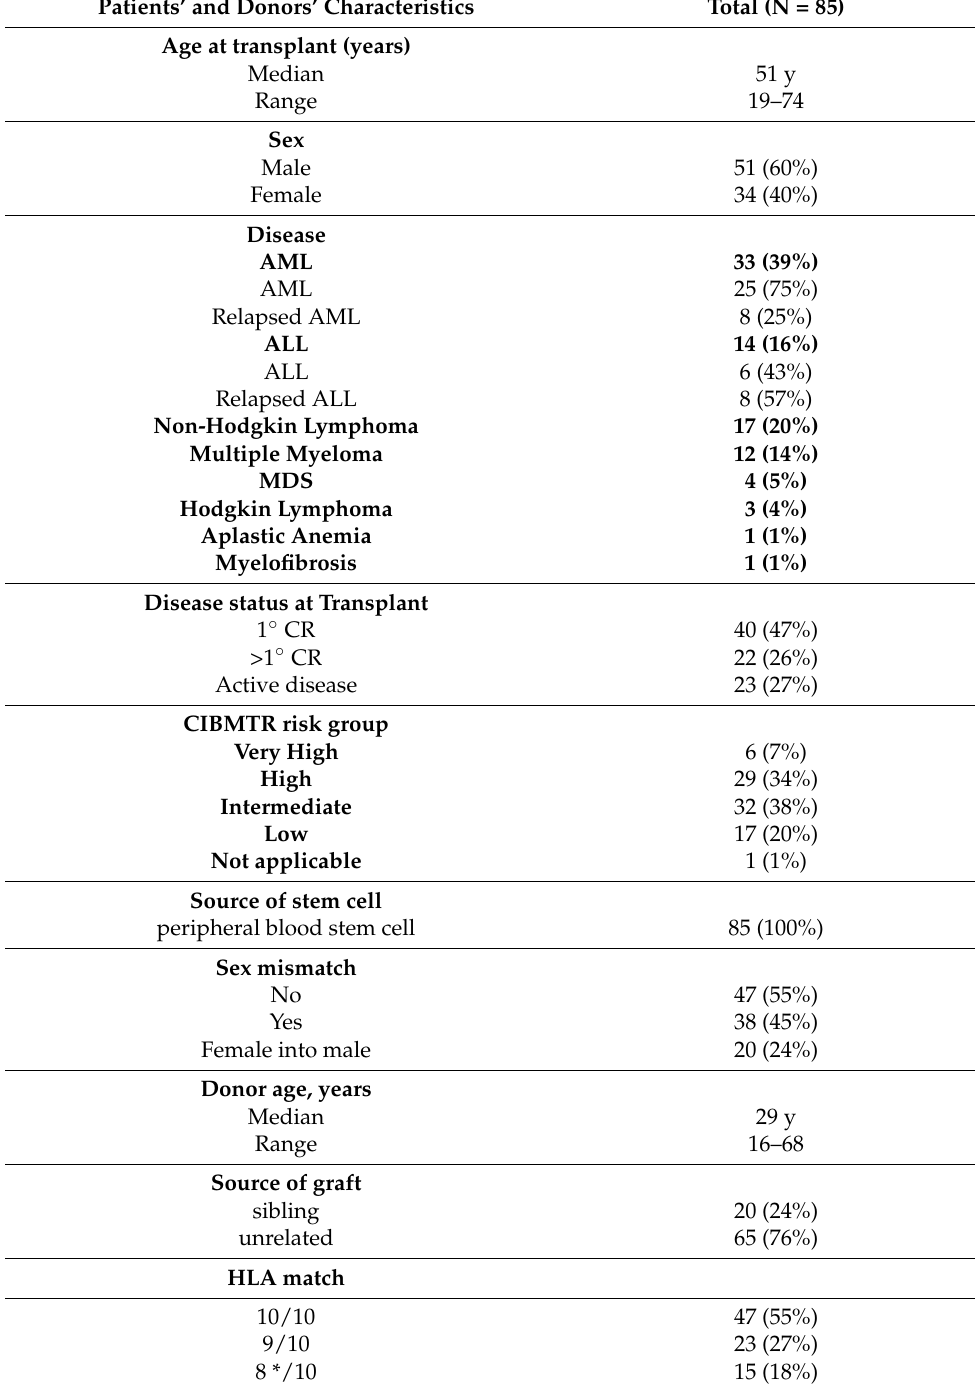
Table 1. Patient and Donor Characteristics. AML: acute myeloid leukemia; ALL: acute lymphoblas- tic leukemia; MDS: myelodisplastic syndrome; BMT: bone marrow transplantation; CR: complete response; MDR: minimal residual disease; TBI: total body irradiation; MMF: mofetil mycopheno- late; CMV (Cytomegalovirus); D (donor); R (recipient). Disease risk corresponding to Center for International Blood and Marrow Transplant Research CIBMTR classification. * Two patients had an antigen disparity at DQA1; Cyclophosphamide was also given before alloPBSCT at 14.5 mg/kg on two consecutive days. ◦ Cyclophosphamide was also given before PBSCT at 10 mg/kg on two consecutive days. CD 34+ cell doses of cell were available for all patients; CD3+ doses only for 89% of